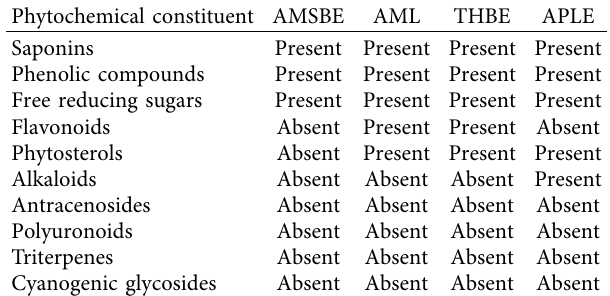
50 of the extracts against P. falciparum, T. brucei,